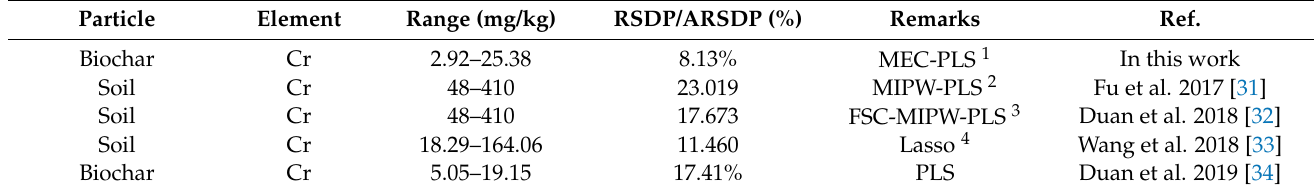
Table 3. Cr detection in biochar and soil in related